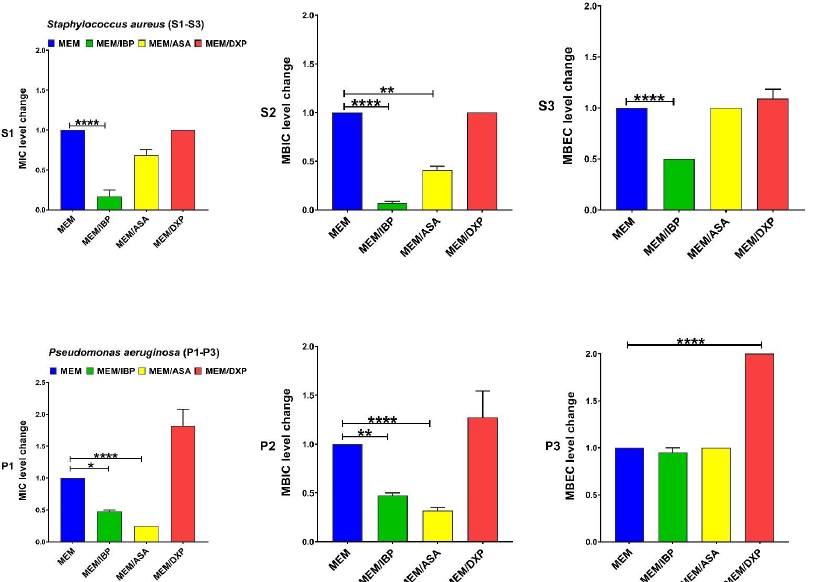
Figure 4. Effects of sub-MICs of ibuprofen (IBP: 200 µ g/mL), aspirin (ASA: 200 µ g/mL), and dexamethasone sodium phosphate (DXP: 500 µ g/mL) on the level of MIC, MBIC, and MBEC of meropenem (MEM) for clinical isolates. Graphs were drawn based on fold changes of MIC, MBIC, and MBEC for MEM in combination with sub-MICs of IBP, ASA, and DXP on clinical isolates. Data are displayed as the mean ± standard error of the mean from 3 replicate experiments and were analyzed using ANOVA and nonparametric Kruskal–Wallis test (S1–S3 for S. aureus isolates and P1–P3 for P. aeruginosa isolates). IBP significantly decreased the levels of MIC, MBIC, and MBEC for MEM among clinical isolates of S. aureus and MIC and MBIC among P. aeruginosa isolates. ASA significantly decreased the level of MIC for MEM among clinical isolate S. aureus and MIC and MBIC for MEM among P. aeruginosa isolates. DXP only significantly increased the level of MBEC for MEM among clinical isolates of P. aeruginosa . *, statistical significance with p ≤ 0.05; **, statistical significance with p ≤ 0.01; and ****, statistical significance with p ≤ 0.0001.